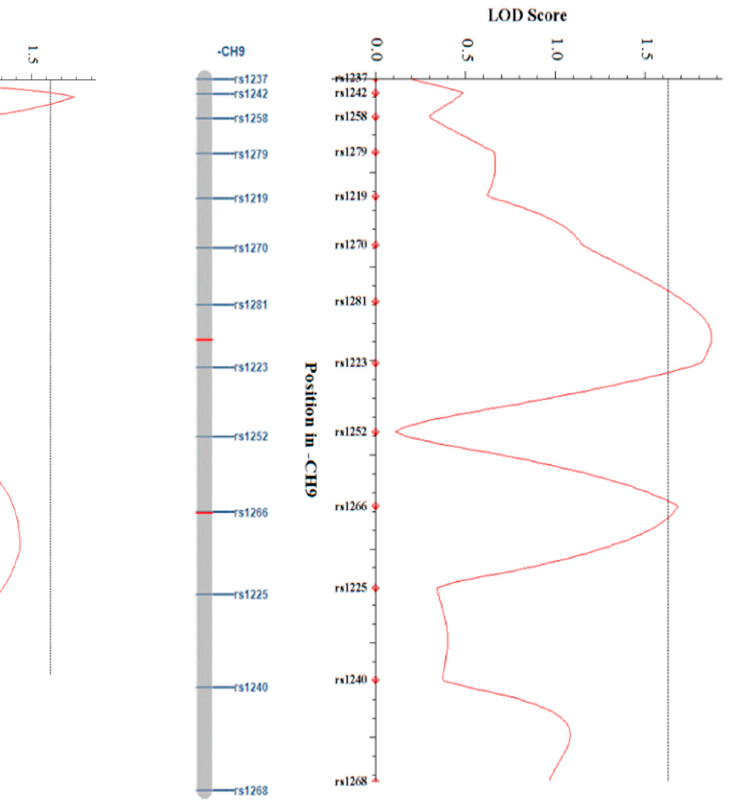
Figure 5. Logarithm of odds (LOD) score plots for chromosomes containing QTL with LOD scores (GX50). The horizontal lines indicate the thresholds for the LOD.